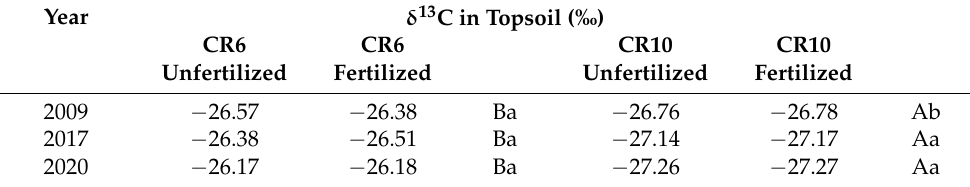
Table 2. Isotope delta values of soil organic carbon in the 0–30 cm layer of CR6 (50% maize) and CR10 (no maize) in three different years after the start of the experiment in 2004. Fertilized treatments received biogas digestate. Different uppercase letters represent significant differences between crop rotations in a specific year and different lowercase letters represent significant differences between years in a specific crop rotation, both at a significance level of p < 0.05. Due to no significant effect or interaction of fertilization, data were pooled over fertilizer treatments prior to comparisons of